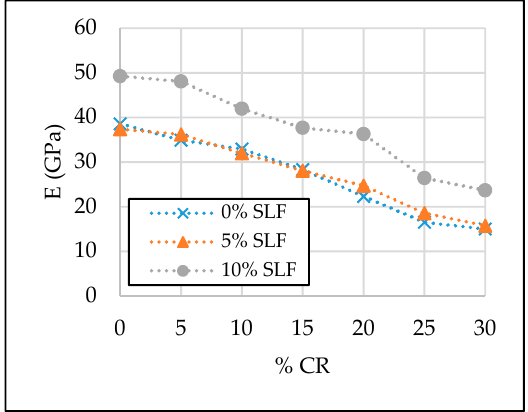
Figure 13. The e ff ect of crumb rubber and silica fume on 28-day modulus of Figure 13. The effect of crumb rubber and silica fume on 28-day modulus of elasticity.